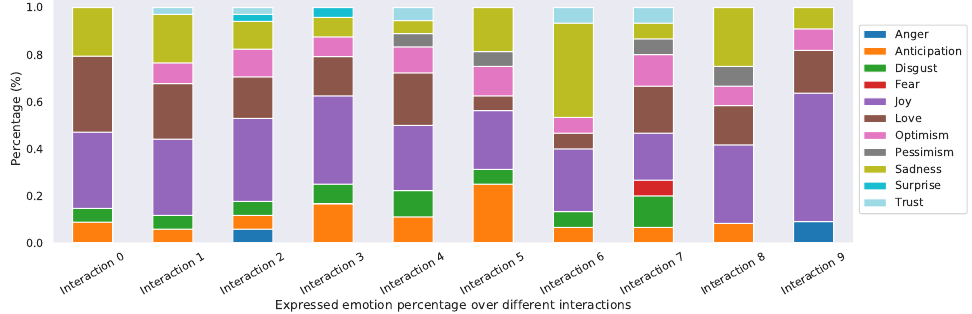
Figure 9. Emotion expressed as a proportion over different interactions (An interaction is when a user initiates a chatbot function. This can be a conversation, activity, or other chatbot